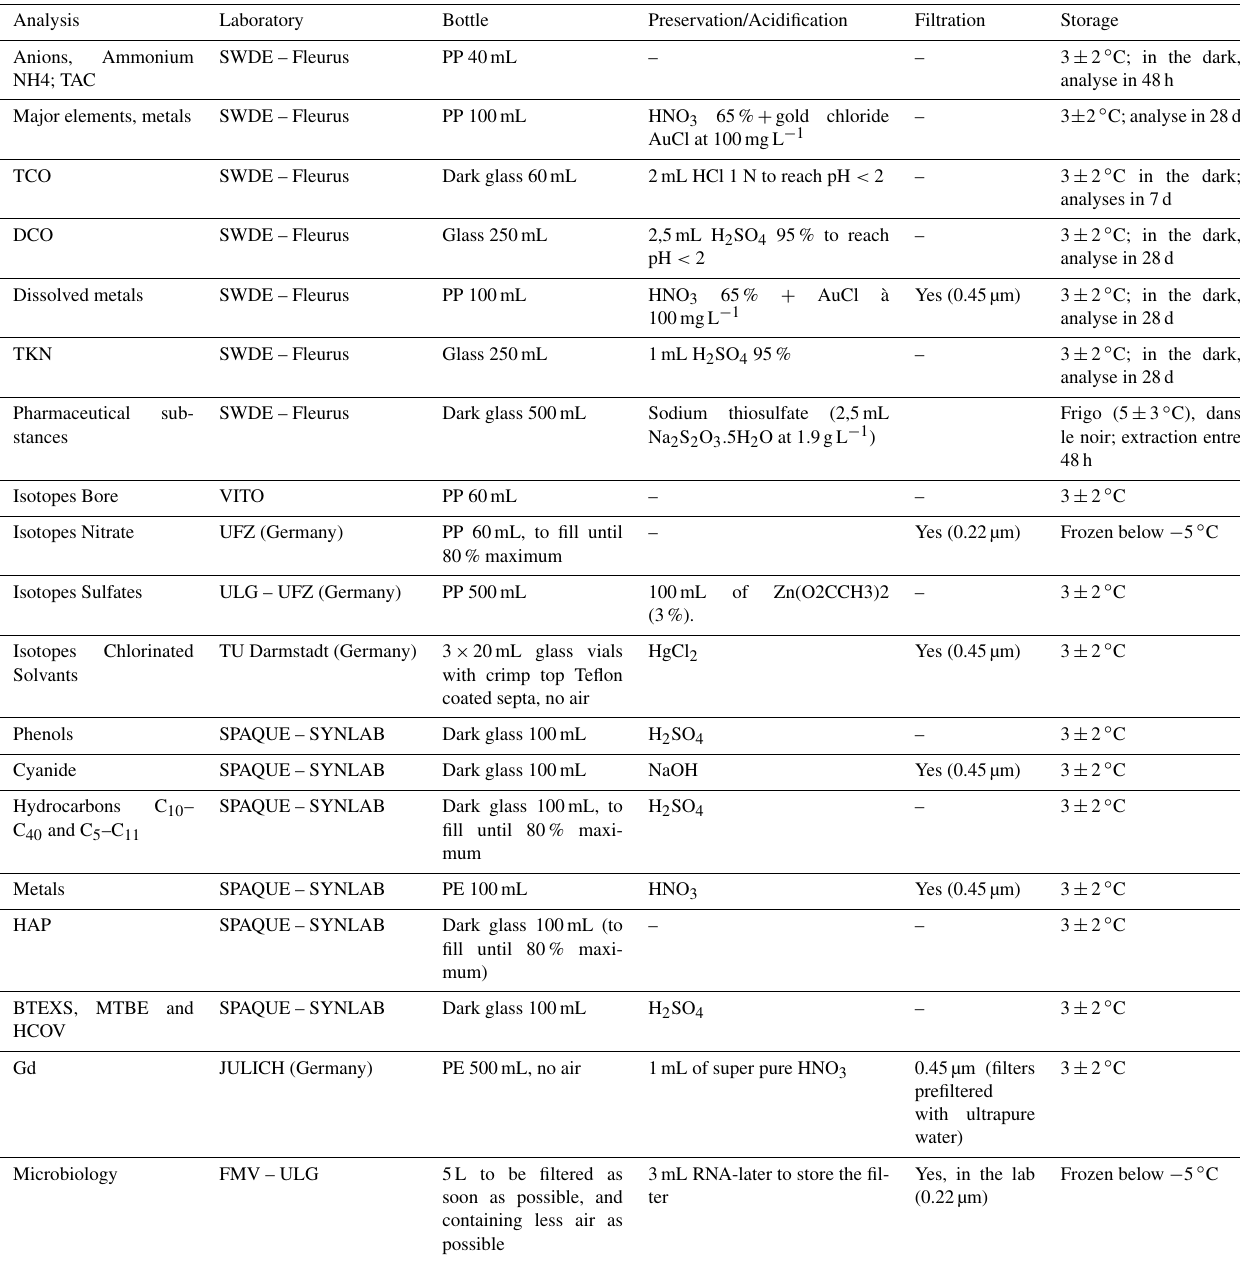
Table 1. Sampling details on the different analysis